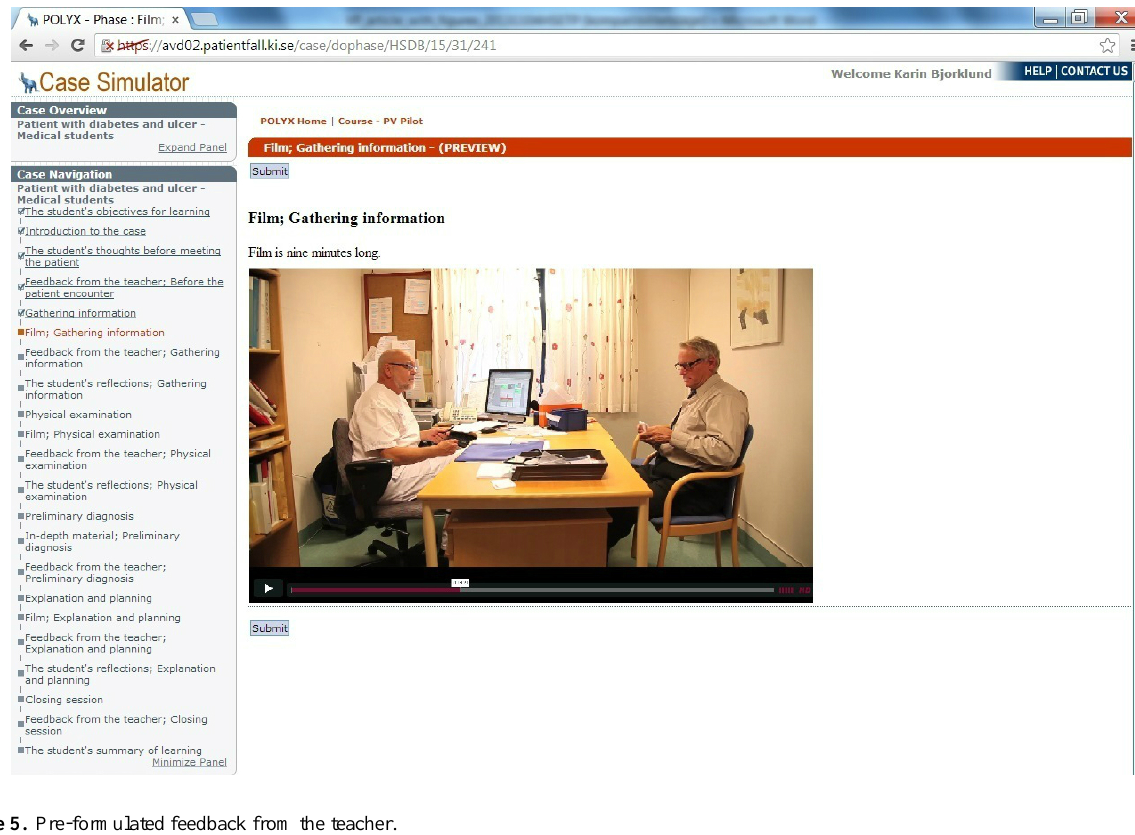
Figure 4. Concrete experience.